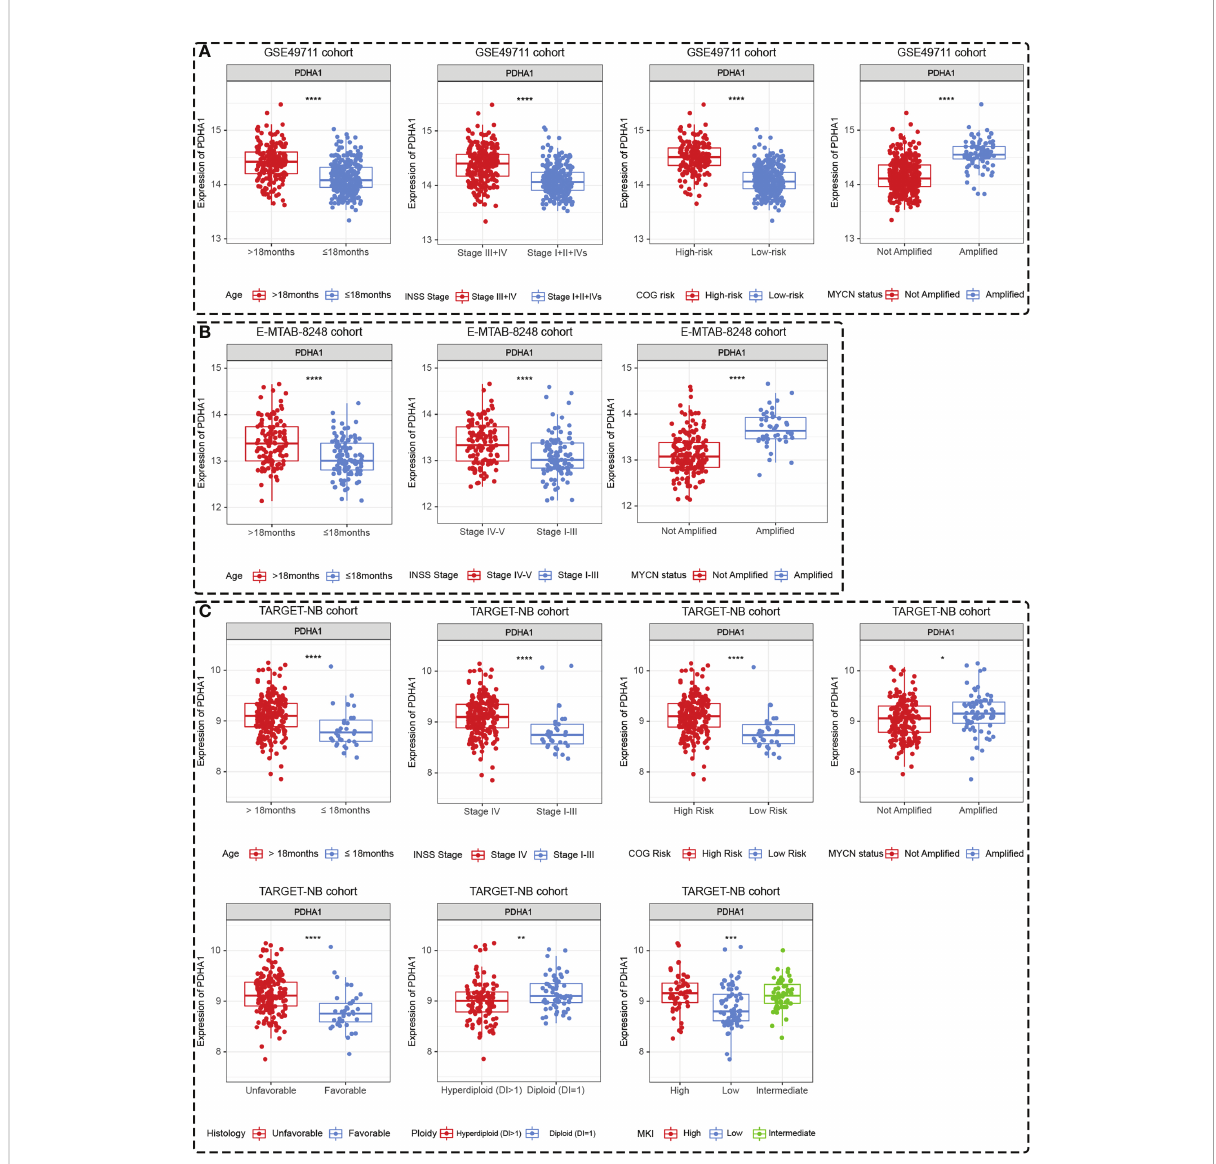
FIGURE 10 PDHA1 presented tissue-speci fi c expression patterns in all three datasets. PDHA1 presented tissue-speci fi c expression patterns in terms of age, Inss stage, COG risk, and MYCN status in GSE49711 dataset (A) , in terms of age, Inss stage, and MYCN status in E-MTAB-8248 dataset (B) , and in terms of age, Inss stage, COG risk, MYCN status, histology, ploidy, and MKI in TARGET-NB dataset (C) . *, **, ***, and **** indicate a signi fi cance level of 0.05, 0.01, 0.001, and 0.0001,